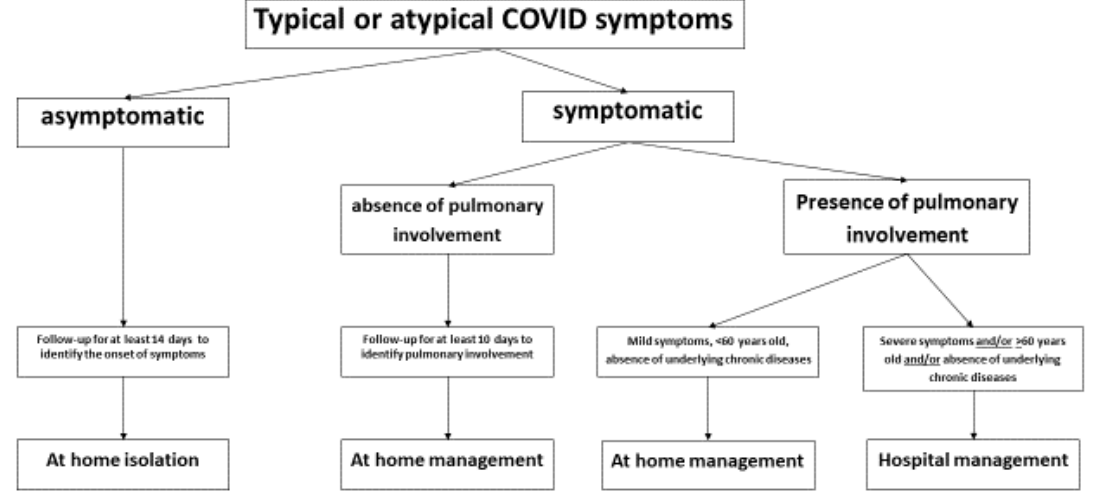
Figure 1. Management of COVID-19 patients according to the clinical